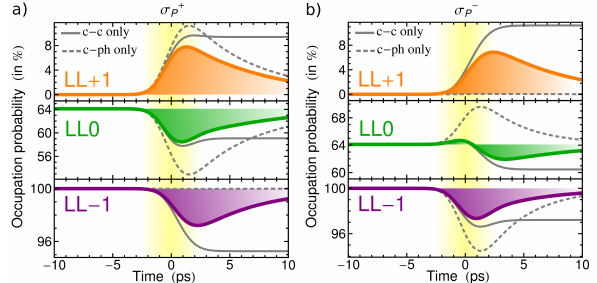
Figure 10: Landau level occupations for pumping with circularly polarized light. Temporal evolution of the three energetically lowest Landau levels after a σ + (a), and σ − -polarized excitation (b).